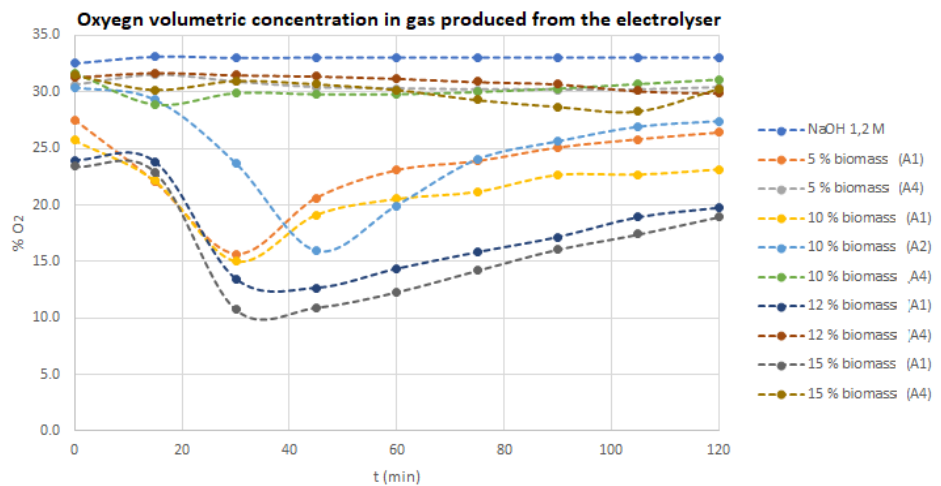
Figure 4. Evolution of the oxygen concentration in the electrolyser, over time, for different tested electrolytes (average values).